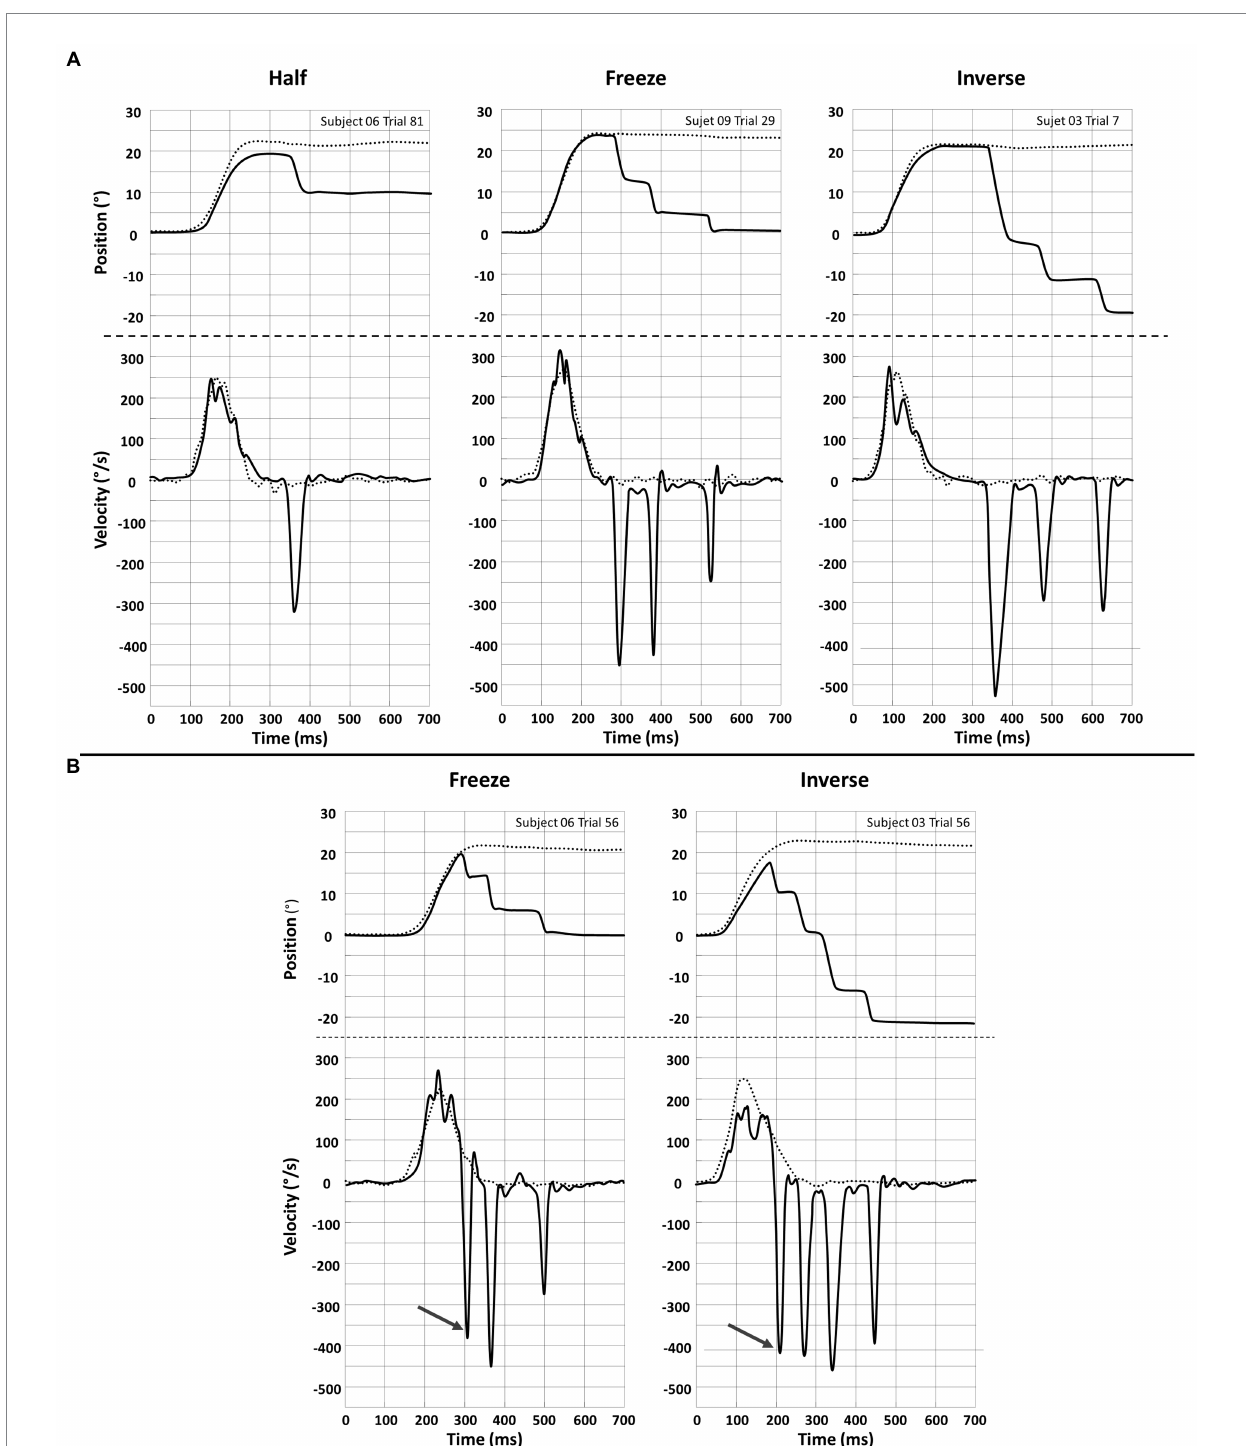
FIGURE 6 Recording of Head ( ……. ) and eye ( ___ ) position (upper plots) and velocity (lower plots) for a single head impulse in the Half, Freeze and Inverse VR setting. Eye positions are inverted in the plot by convention. (A) Responses with overt saccades only. (B) Responses with a covert saccade (arrow) preceding overt